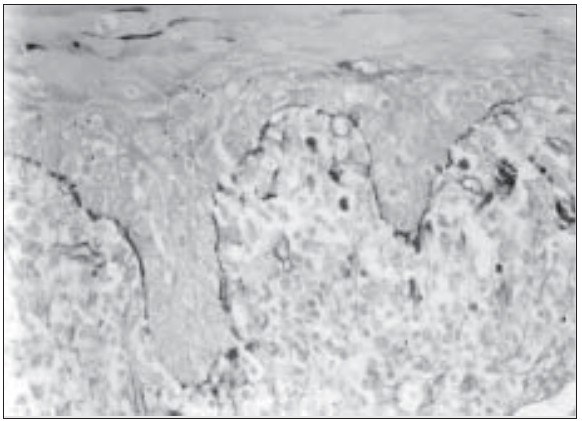
Figura 13 – Avaliação da camada basal em 59 biópsias de líquen plano cutâneo e oral